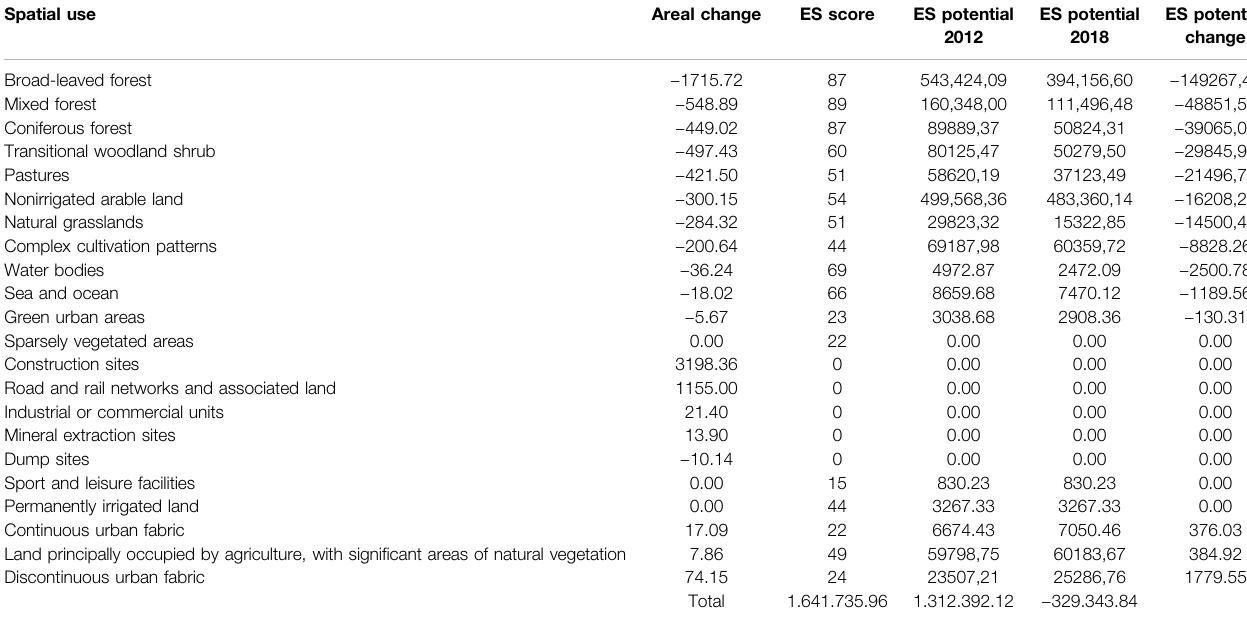
TABLE 3 | ES potential change between 2012 and 2018 in the NMM impact zone. Spatial use